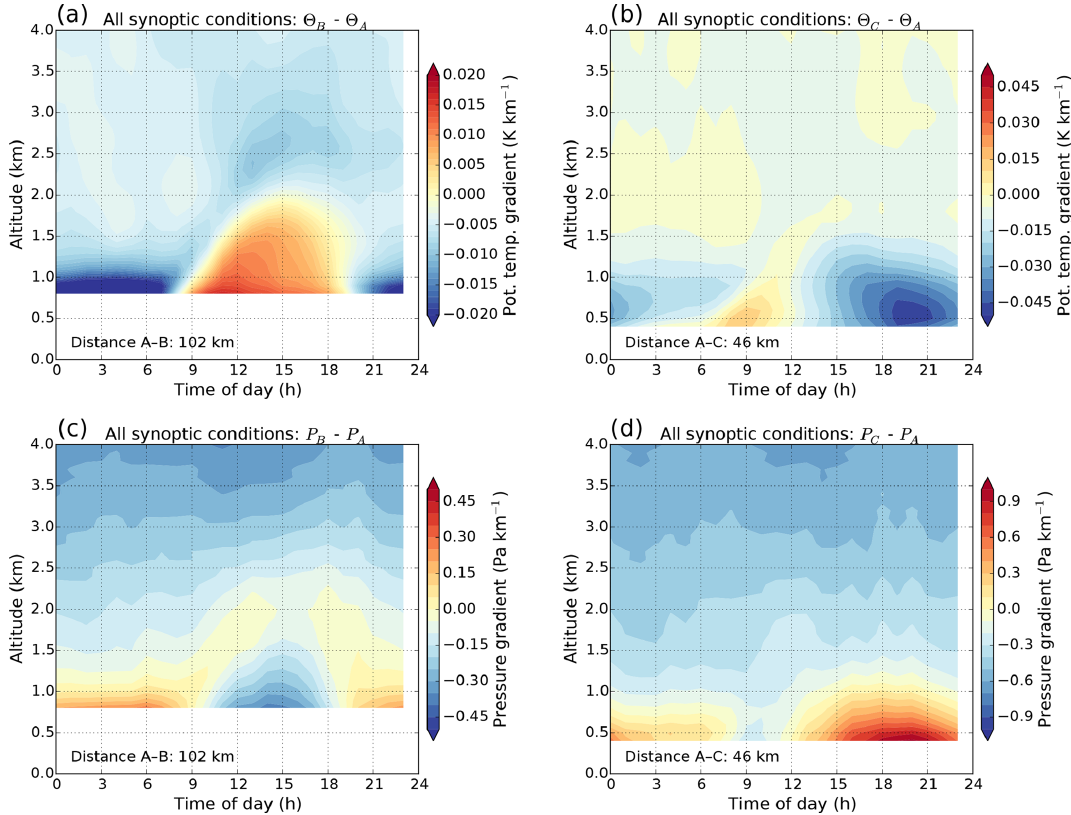
Figure 14. WRF D2 mean diurnal vertical profiles of horizontal potential temperature (cid:50) and pressure P gradients between (a, c) regions A and B and (b, d) regions A and C. The locations of the regions are marked in Fig. 10. The averaging period was 1 May to 15 June